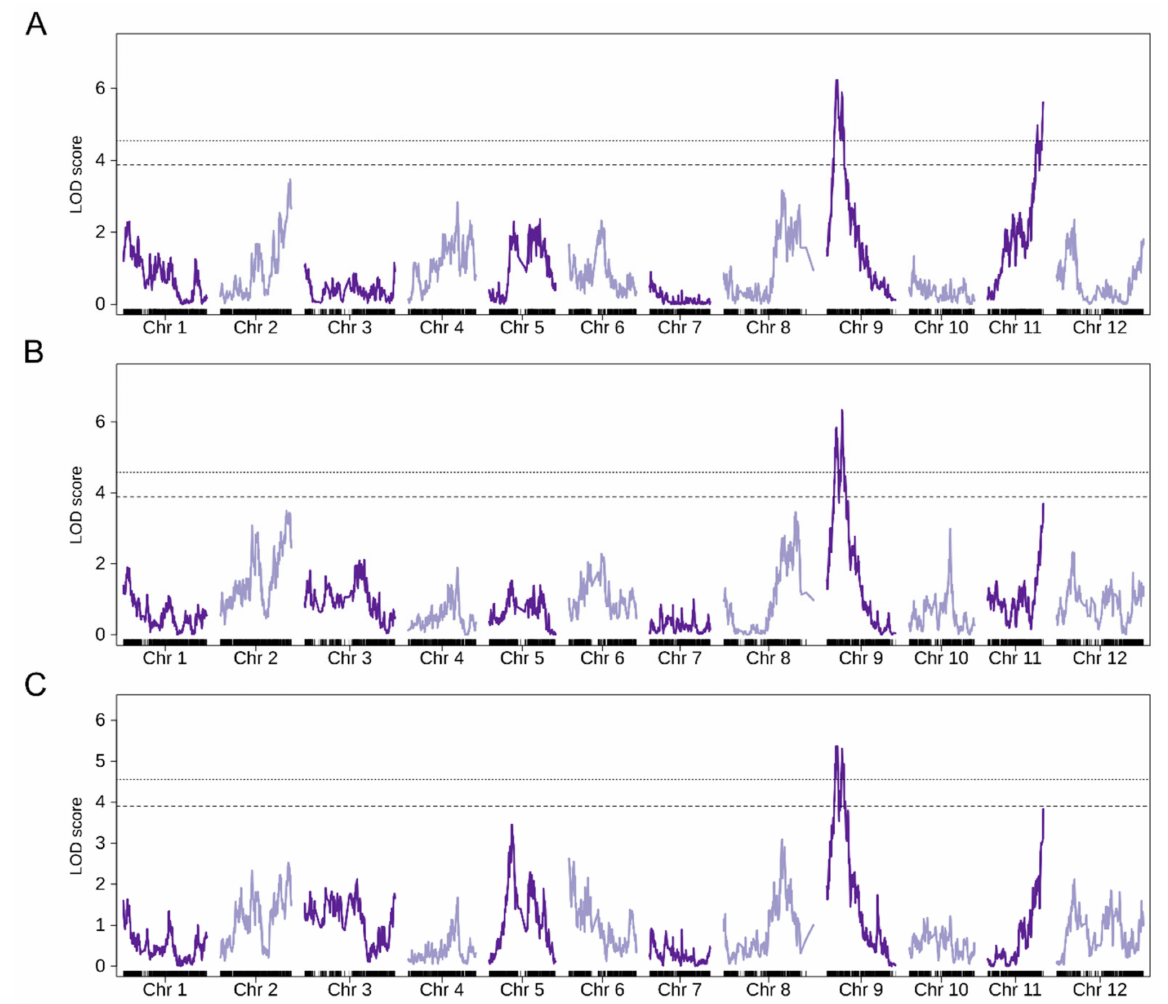
Figure 3. Results of non-parametric single interval mapping QTL analysis for each of the three weeks phenotyped. ( A ) 6th week after transplanting, ( B ) 7th week and ( C ) 8th